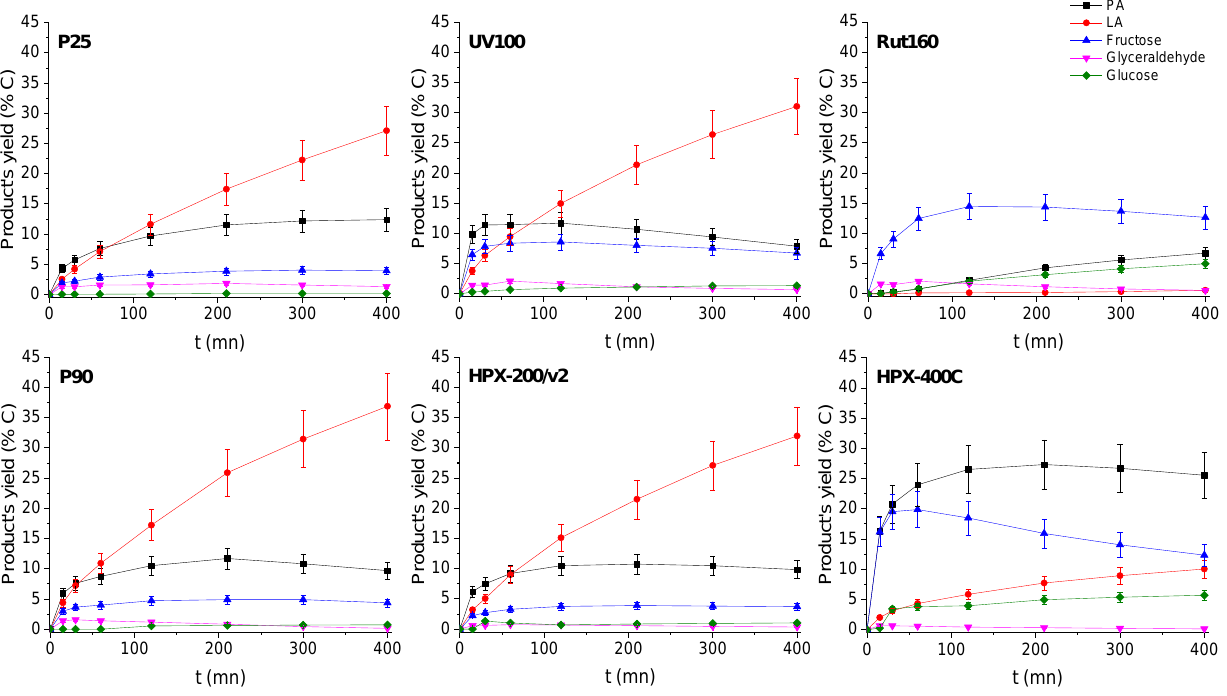
Figure 7. Products’ yield time course in the presence of the six TiO 2 s. Conditions: T = 90 °C, P air = 1 atm, V water = 200 mL, (DHA) = 0.1 mol.L −1 , (TiO 2 ) =10 g.L −1 .